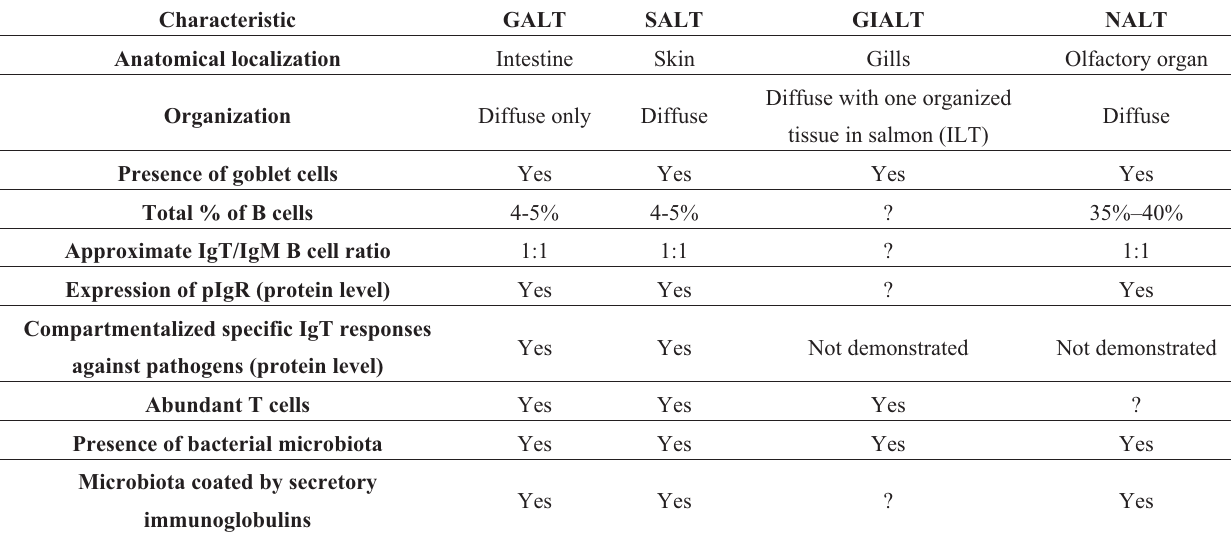
Table 1. Summary table of the main characteristics of teleost MALT. ? = unknown, not studied. ILT: interbranchial lymphoid